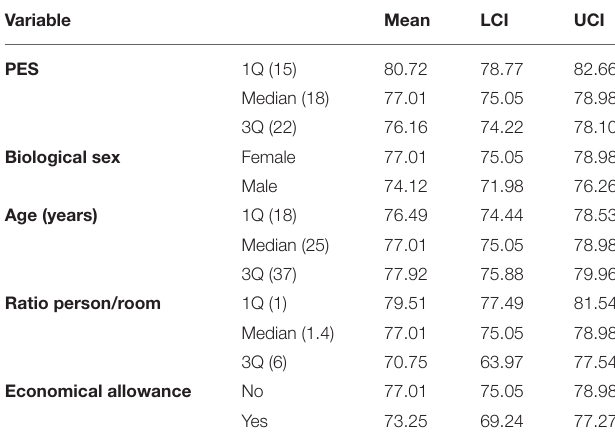
FIGURE 1 | Association between diet quality and stress. Predicted means of GDI and respective 95% confidence intervals are shown for different levels of stress. An inverse nonlinear association between diet quality and stress is shown in that, a worse diet quality is associated with higher levels of stress. Data was modeled using linear regression with resctrictive cubic splines (see Methods section).